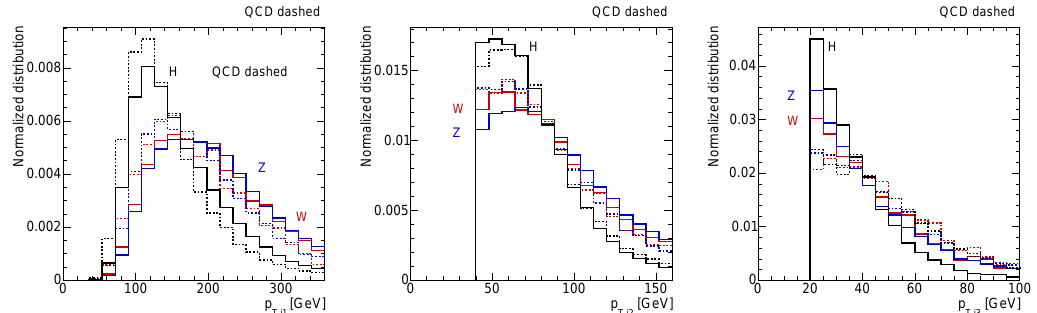
Figure 9: Transverse momentum distribution of the three jets for the WBF signal and the EW and QCD (dashed) V + jets background, after the pre-selection cuts of Eq.(3).